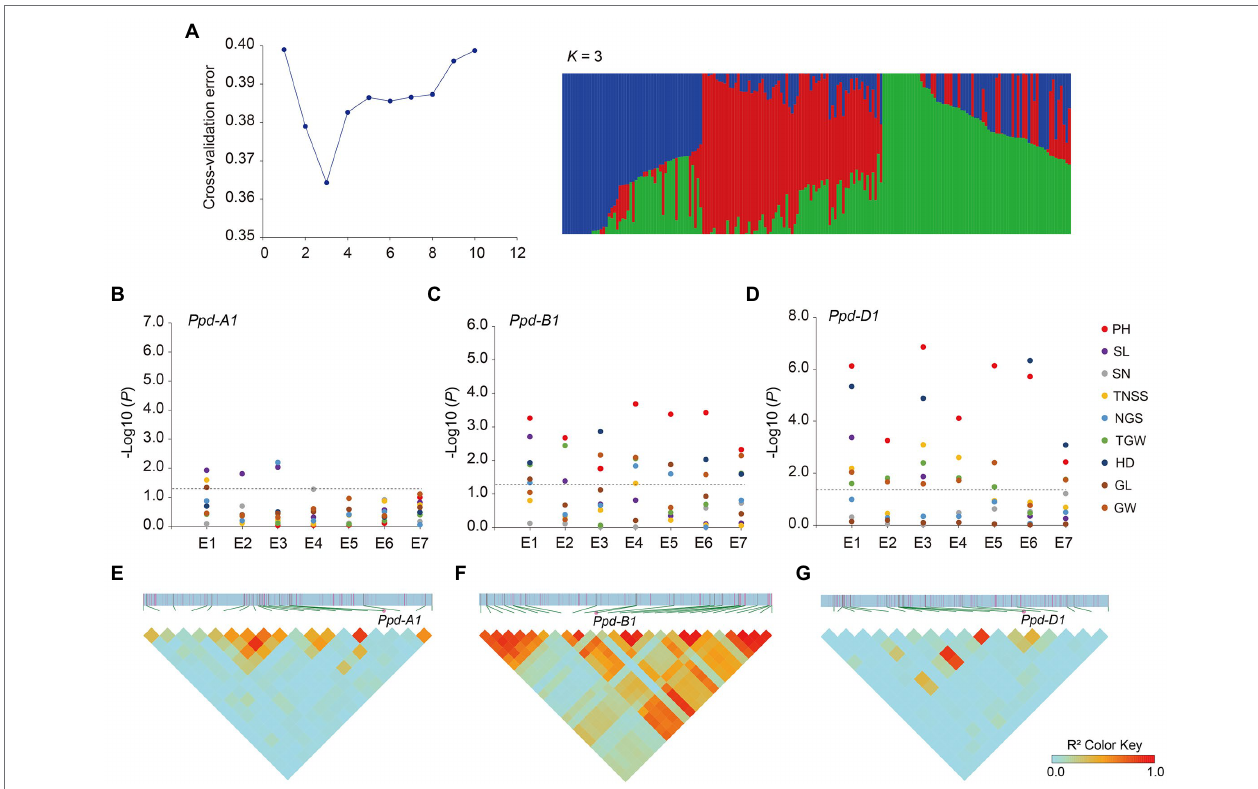
FIGURE 3 | Population structure, association analysis, and linkage disequilibrium analysis. (A) Population structure of the natural population. Plot of cross- validation (CV) error against putative k ranging from 1 to 10 (left). Stacked bar plot of ancestry relationship of 188 accessions when k = 3 (right). (B) Genome-wide association analysis of Ppd-A1 . (C) Genome-wide association analysis of Ppd-B1 . (D) Genome-wide association analysis of Ppd-D1 . PH, plant height; SL, spike length; SN, spike number; TNSS, total number of spikelets per spike; NGS, number of grains per spike; TGW, thousand-grain weight; HD, heading date; GL, grain length; and GW, grain width. E1–E7 indicate the environments. Negative log 10 -transformed p values are plotted. The black horizontal dotted line indicates the threshold value for significant associations ( p < 0.05). (E) Linkage disequilibrium analysis spanning the physical position from 36.627 to 46.152 Mb of